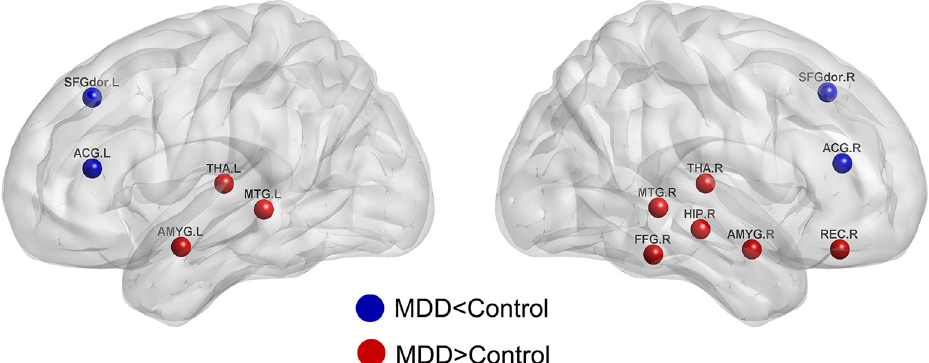
Fig 4. Regions exhibited significant between-group differences in regional nodal parameters. The blue color represented the higher values of regional nodal centralities in healthy controls, and the red color represented the higher values of regional nodal centralities in MDD patients ( p < 0.05, FDR